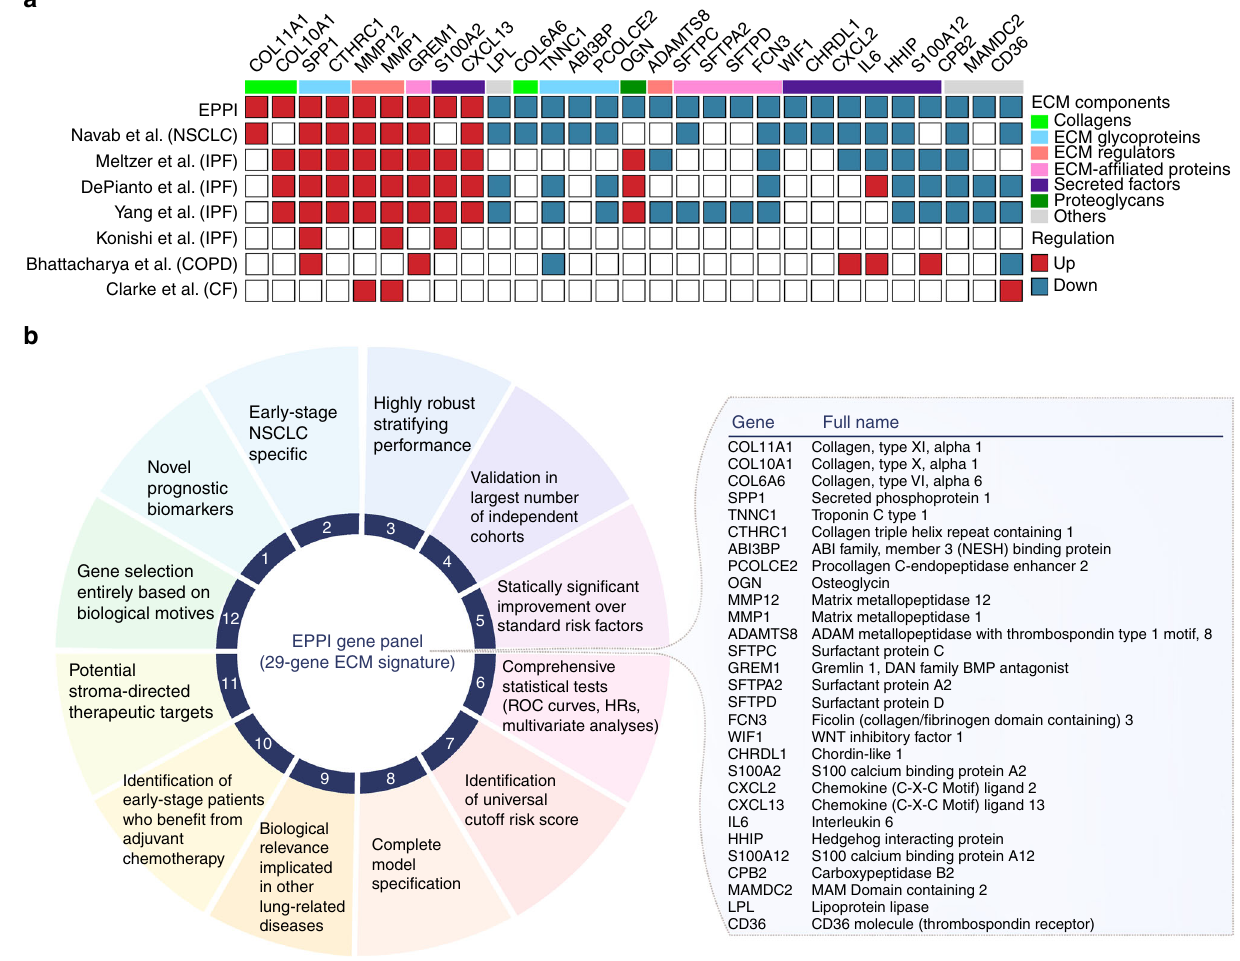
Fig. 7 Biological and clinical signi fi cance of the EPPI gene signature. a Schematic representation of the expression patterns of the EPPI gene signature in lung cancer and other lung-related diseases. Differential expression levels in prior works were calculated using their own statistical methods from diseased lung tissues vs. matched normal lung tissues. b Summary of our gene panel in terms of critical factors to be considered in developing gene expression- based prognostic EPPI classi fi er validation and its prognostic evaluation . To validate the prog- nostic value of the EPPI in predicting OS and RFS, normalized gene expression pro fi les (log2 transformed) from eight independent microarray data sets across four different platforms of Affymetrix (HG-U133A and HG-U133_Plus_2), Illu- mina (HumanWG-6 v3.0 Expression), and Agilent (014850 Whole Human Gen- ome Microarray 4× 44K G4112F) were downloaded via the GEO repository directly. For all validation cohorts, manual curation was done to select only pri- mary tumors resected from stage IA to IIB (early-stage) patients and the survival data were censored at 10 years follow-up post surgery. Using a Spearman rank correlation as a distance metric selection, an unsupervised hierarchical clustering algorithm was fi rst performed to test the prognostic value of the EPPI signature in the validation cohort (Supplementary Fig. 1) using the Institute of Genomic Research MultiExperiment Viewer (TIGR MeV) version 10.2 software. The EPPI risk score of each patient was then computed and used to divide patients into low and high-risk group based on the optimal cutoff score identi fi ed in each data set. The optimal cutoff EPPI risk score, which is de fi ned as the score with the most signi fi cant split using log-rank test, was determined using the Cutoff Finder algorithm 40 . Personalized EPPI risk score and gene expression heat maps . The regression coef fi cient of each EPPI gene was derived from 489 early-stage NSCLC patients who had complete survival information from the initial discovery set. The EPPI risk score was calculated as a sum of multiplication of the expression level of each EPPI gene and its respective Cox regression coef fi cient identi fi ed from the dis- covery set (EPPI risk score = 29+ ∑ (expression level of gene) X (Cox regression coef fi cient)). Each Cox regression coef fi cient used for EPPI risk score computation is shown in Supplementary Table 3. A constant was added to ensure all scores are